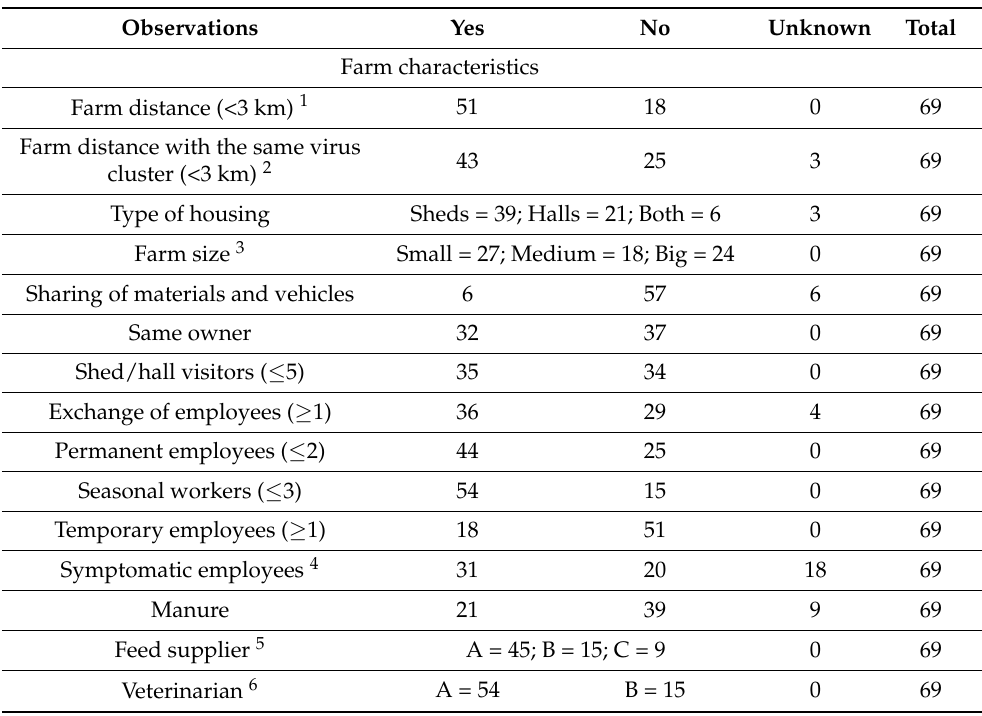
Table 1. Summary of farm and outbreak characteristics and virus types for the 69 mink farms diagnosed with